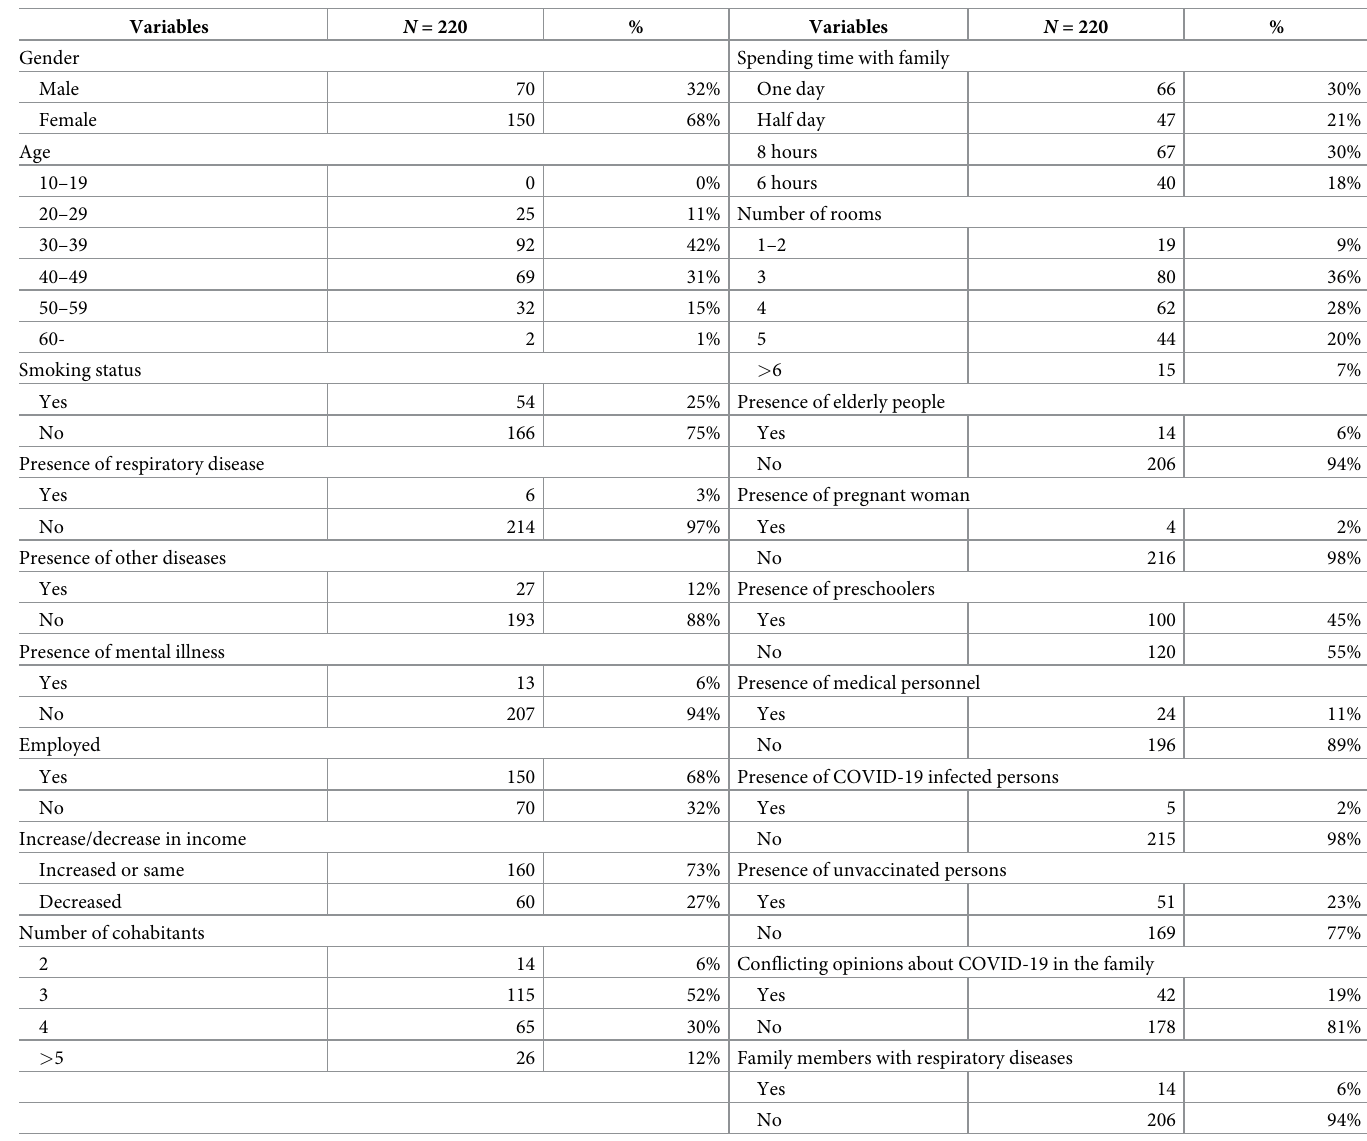
Table 1. Socio-demographic information ( N =